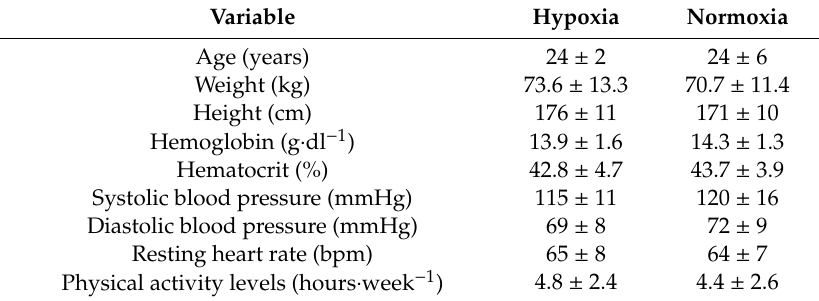
Table 1. Participants’